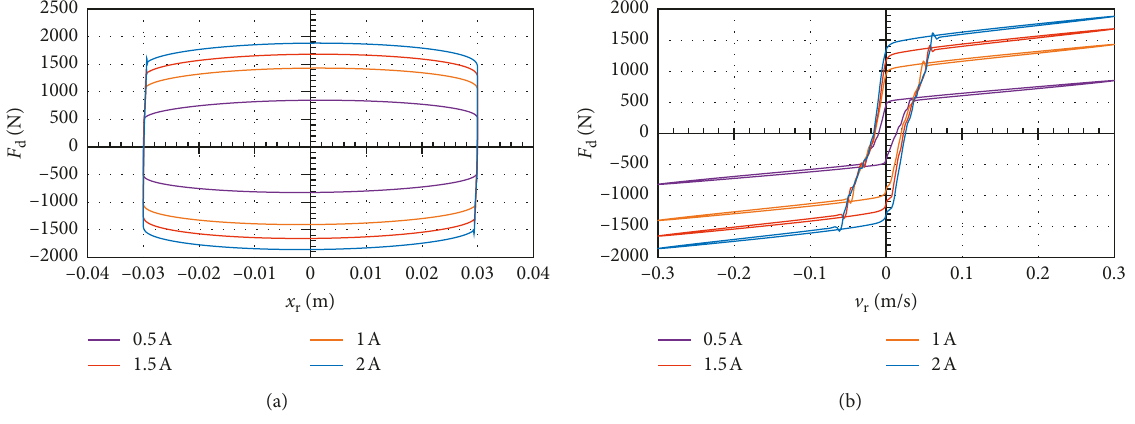
Figure 17: Fixed current: force vs. velocity and force vs. stroke, V